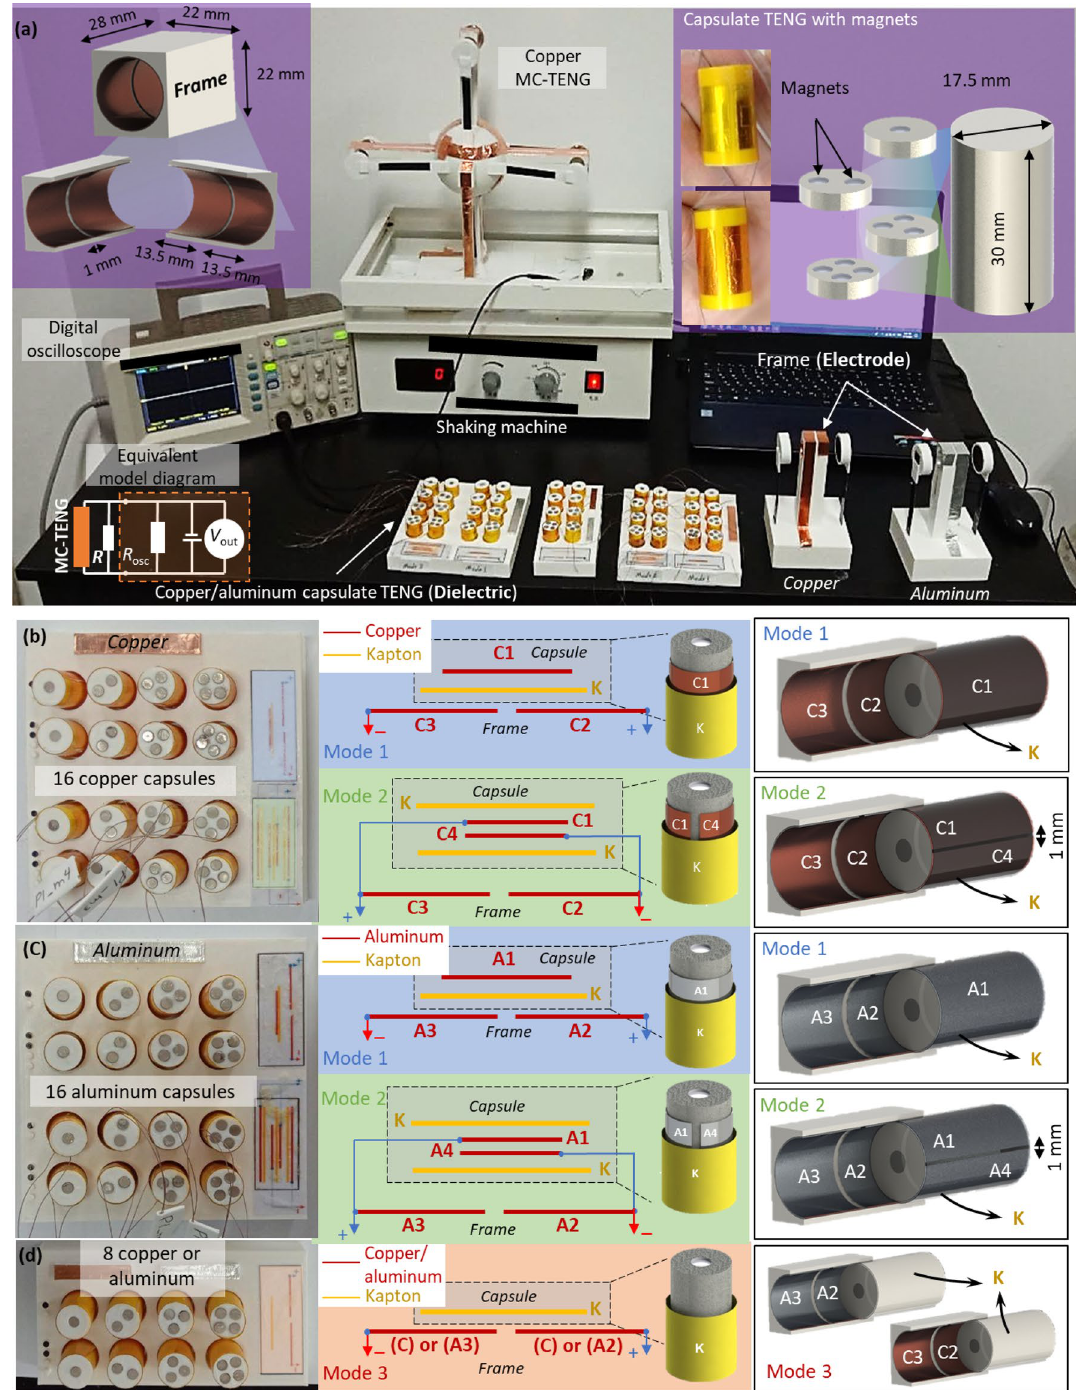
Figure 2. Fabrication of the capsulate TENG and experimental setup of the MC-TENG. ( a ) Experimental setup of the MC-TENG fabricated with the materials of copper and aluminum in the single-layered (mode 1), double- layered (mode 2) and non-layered (mode 3) structures. Design and fabrication of the capsulate TENG using ( b ) copper and ( c ) aluminum in mode 1 and mode 2 with different end magnets. ( d ) Design and fabrication of the copper/aluminum capsulate TENG in mode 3 with different end magnets (all the capsules were fabricated with 1 to 4 end magnets on 1 or 2 layers) (Conceptual images are created by SolidWorks 2017 SP4.1 https:// www. solid works.